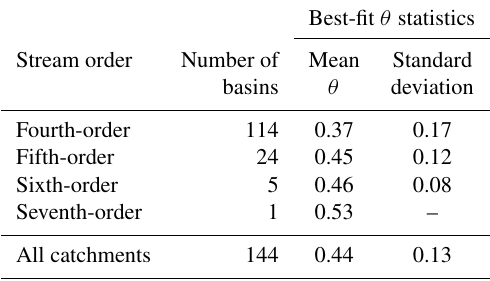
Table 1. Variability in θ in the QF. Best-fit θ values were computed for all catchments of a stream order higher than the third order based on the disorder method (Hergarten et al., 2016) using code devel- oped by Mudd et al.